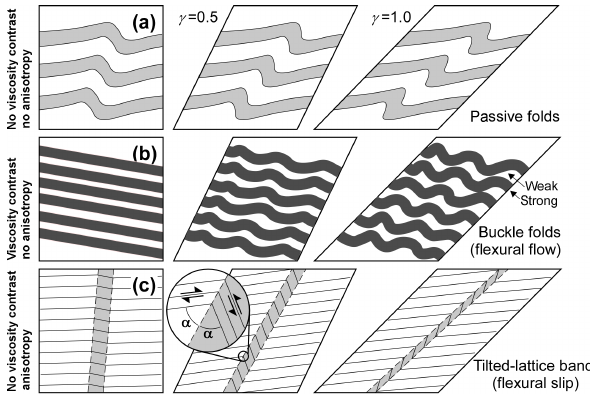
Figure 9. Basic folding mechanisms discussed in the text. (a) Pas- sive folds form by shearing of disturbances in layering, without an active mechanical influence of that layering. Fold geometry is that of similar folds. (b) Buckle folds form by shortening of alternat- ing strong and weak layers, in which the strong layers buckle and weak material flows into fold hinges. Fold geometry is that of par- allel folds. (c) Tilted-lattice bands form in case of strong intrinsic anisotropy, but do not require viscosity contrasts between